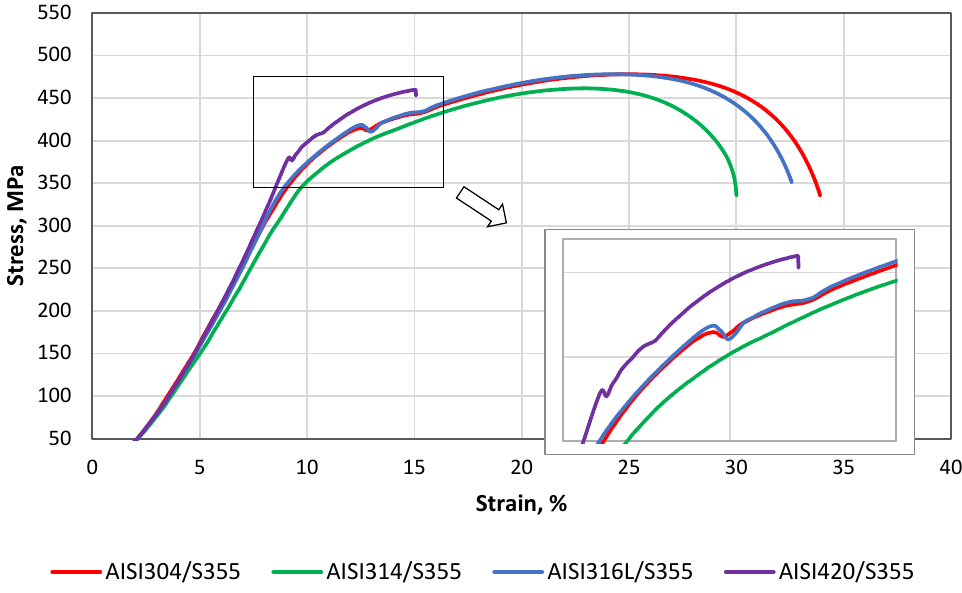
Figure 13. Stress–strain diagrams of dissimilar welds.